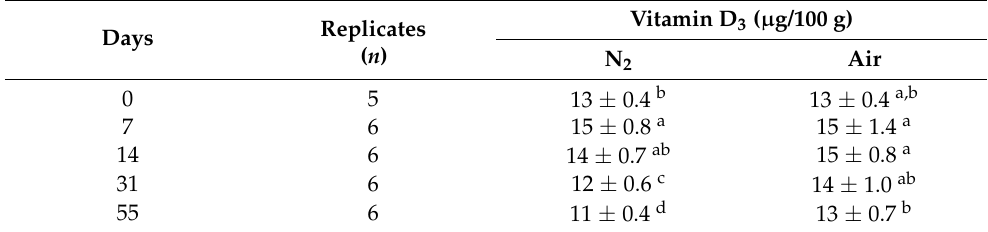
Table 3. Stability of vitamin D 3 during 55 days of storage in a controlled atmosphere of N 2 or air. The values are presented as mean ±